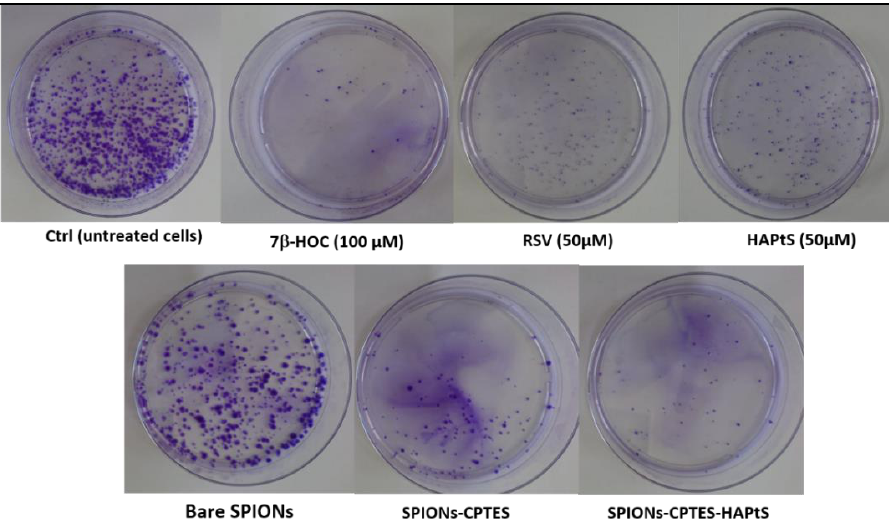
Figure 11. Pictures of Petri dishes of C6 cells at the end of the clonogenic assay (24 h of incubation with nanoparticles or molecules and 8 days of culture). Ctrl (untreated cells), positive cytotoxic control (7 β -OHC, 100 µ M), RSV (50 µ M), HAPtS (50 µ M in RSV equivalent), bare SPIONs (the same amount as in SPIONs-CPTES-HAPtS), SPIONs-CPTES (the same amount as in SPIONs-CPTES-HAPtS), and SPIONs-CPTES-HAPtS (amount equivalent to 50 µM HAPtS).